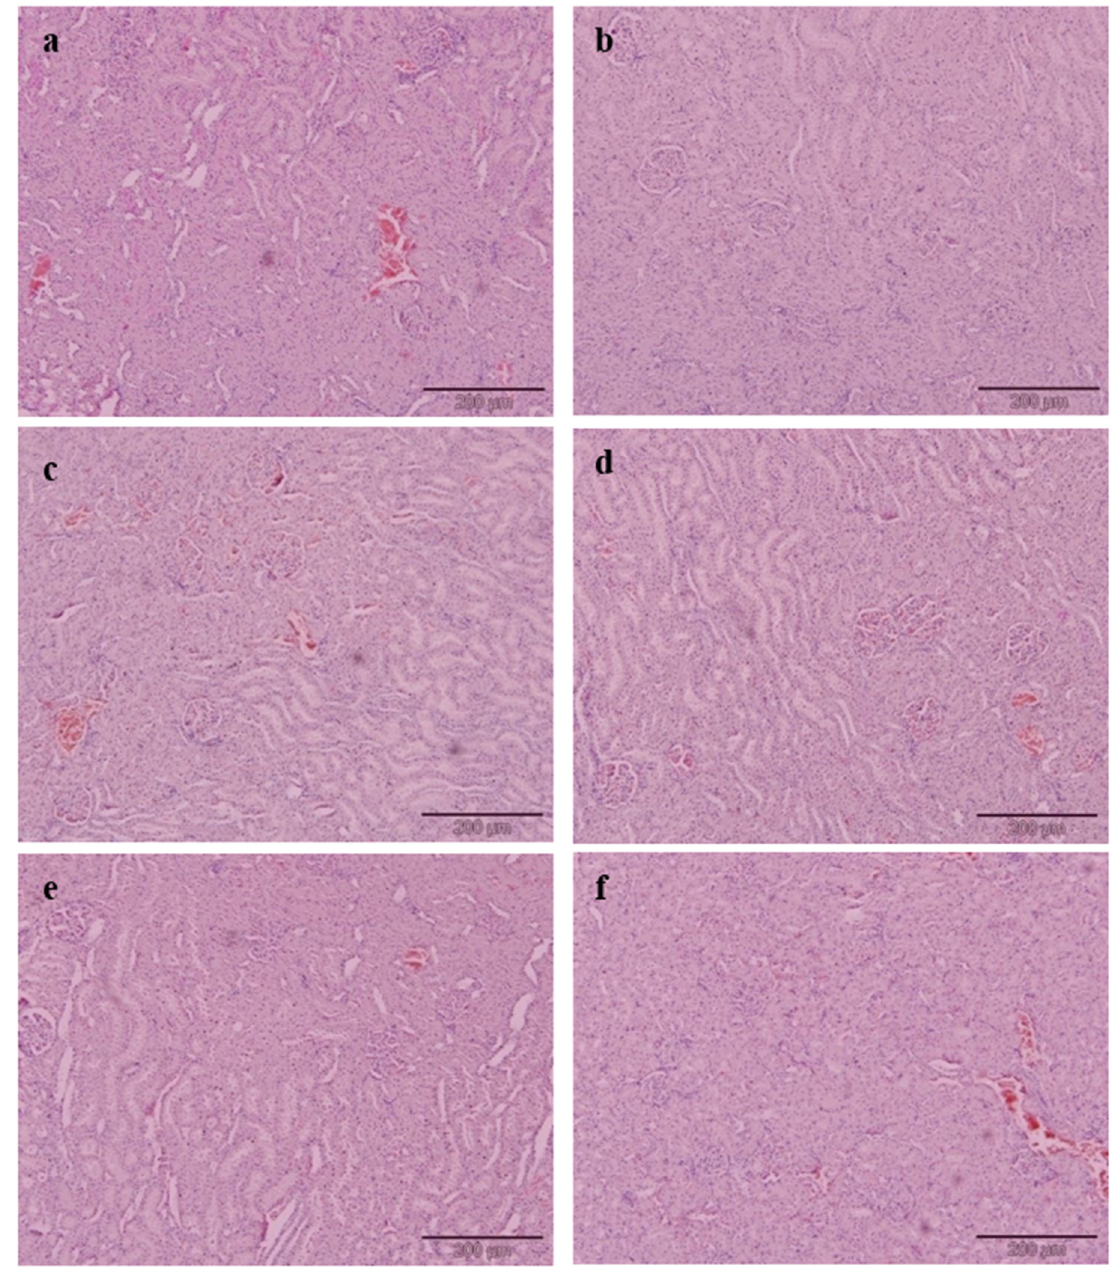
Figure 3. Histology of rat kidney tissue in different groups. ( a ) NC—Normal control, ( b ) PC—Positive control with high cholesterol diet (1%), ( c ) SV—High cholesterol diet (1%) with simvastatin (10 mg/kg body weight), ( d ) EAMMS50—High cholesterol diet (1%) with ethyl acetate Mikania micrantha stem extract (50 mg/kg body weight), ( e ) EAMMS100 High cholesterol diet (1%) with ethyl acetate Mikania micrantha stem extract (100 mg/kg body weight), ( f ) EAMMS200—High cholesterol diet (1%) with ethyl acetate Mikania micrantha stem extract (200 mg/kg body weight). Kidneys were stained with hematoxylin and eosin (H&E) and visualized under a light microscope at 200× g magnification.